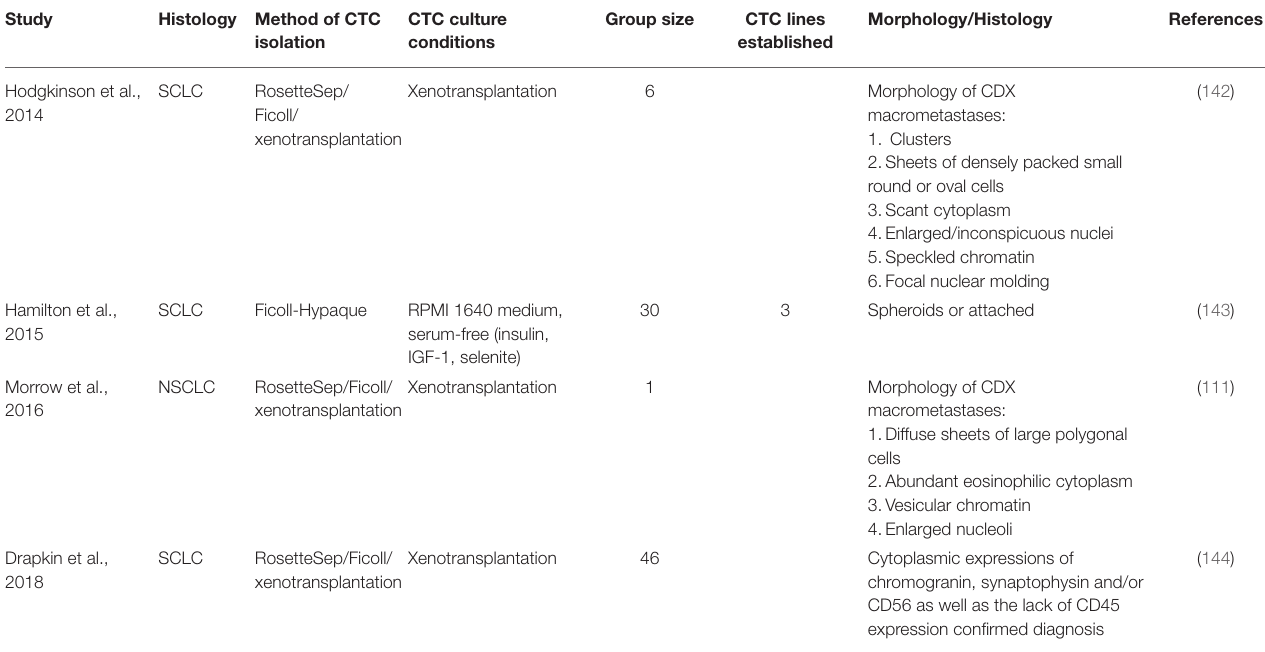
TABLE 5 | Summary of long-term Circulating Tumor Cell culture in Lung cancer.